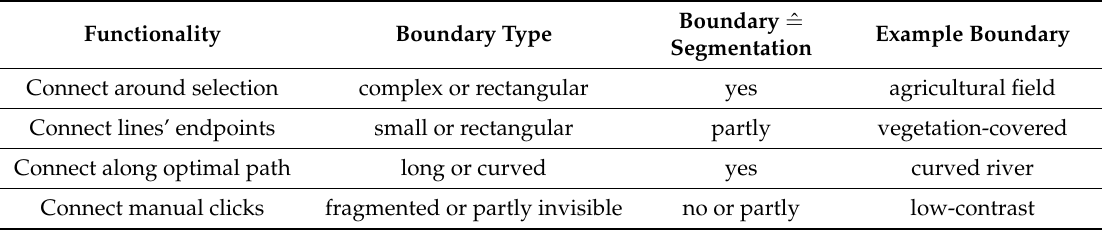
Table 7. Which plugin functionality to use for which boundary